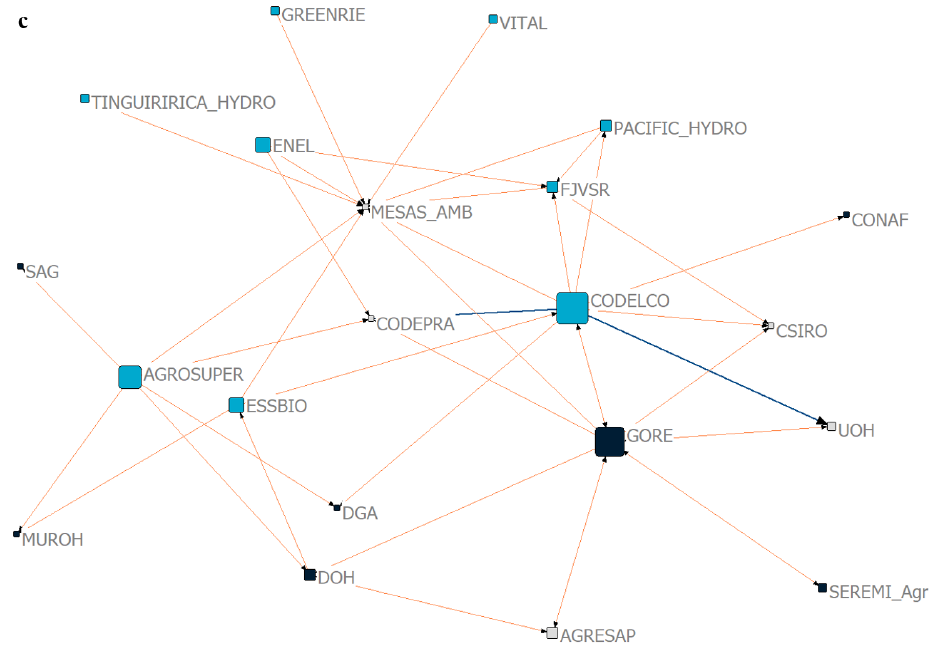
Figure 7. Network degree centrality for: ( a ) collaboration ties; ( b ) information flows; and ( c ) financial exchanges in the